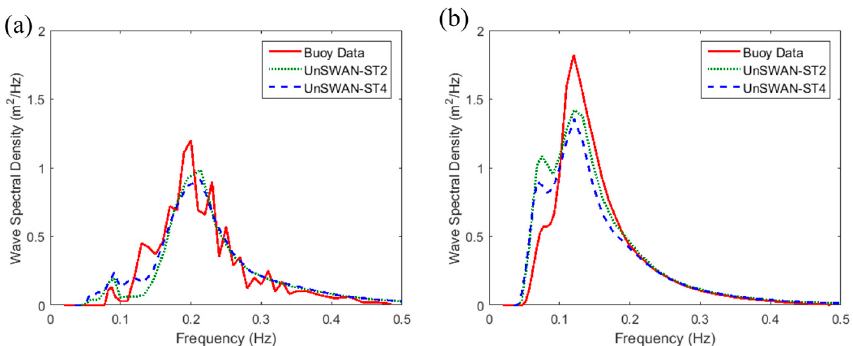
Figure 6. Measured and modeled wave spectra at NDBC Buoy 46050 ( a ) at 1 a.m. on 15 July 2009; and ( b ) the July monthly average, 2009.